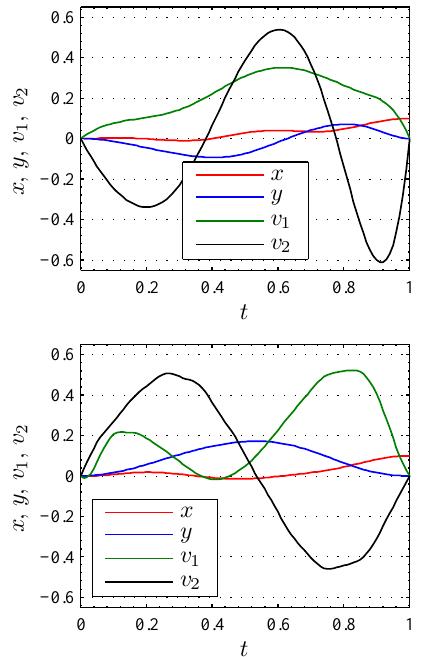
Figure 4. Position and linear velocity: egalitarian solution (top) and prioritarian solution